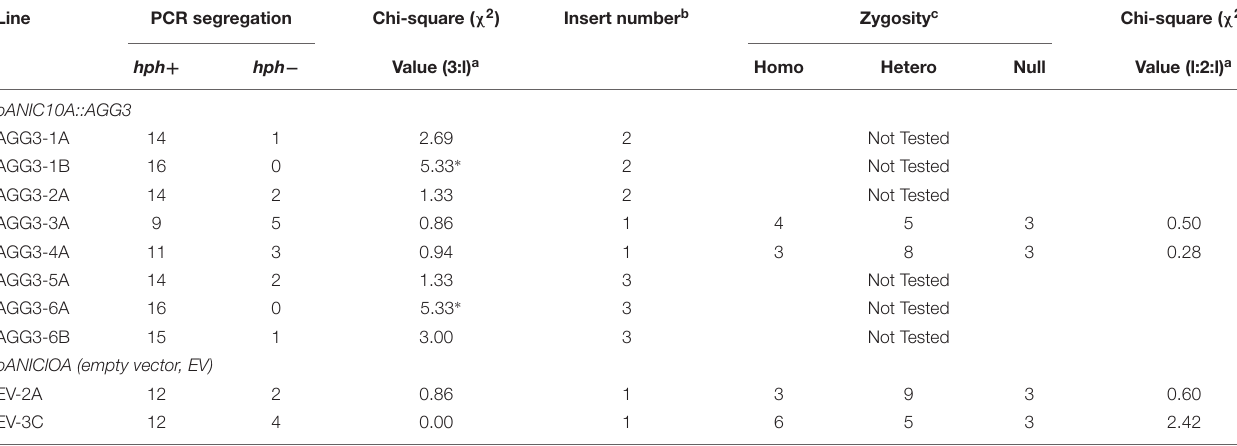
TABLE 1 | Genetic and molecular characterization of transgenic T 1 S. viridis lines.